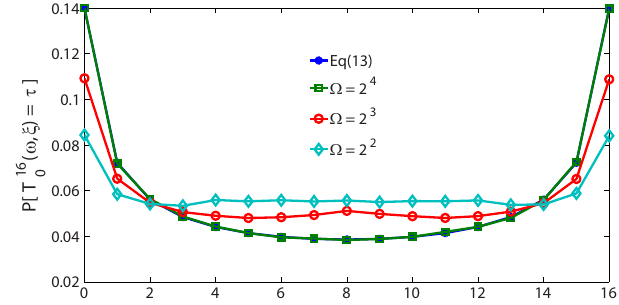
Figure 5. Comparison of Eqs. (13) and (12). We have calculated τ from − 8 to 8, then shifted it to start at 0 to compare with the Eq. (13) which starts at 0. We can see that as (cid:127) gets larger the distribution approaches the analytical result for the random walk, becoming exact for τ f − τ i ≤ (cid:127)